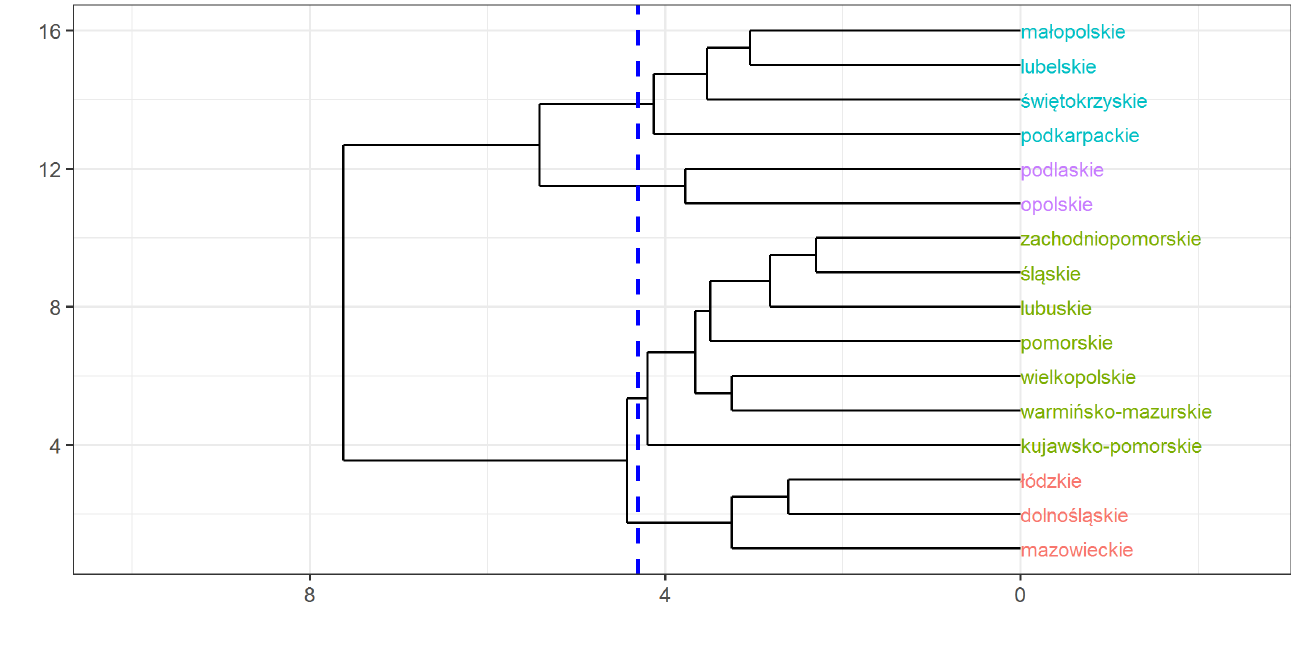
Figure 5. Dendrogram for 16 Polish provinces (the Ward method).